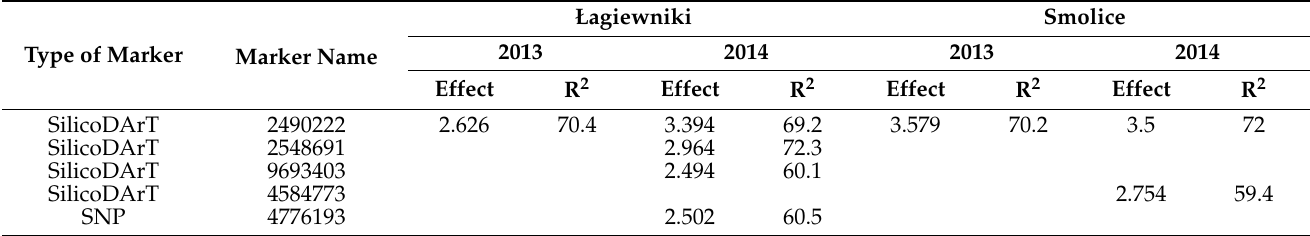
Table 1. Molecular markers significantly (LOD > 3.0) associated with the heterosis effect of cob length (LC).